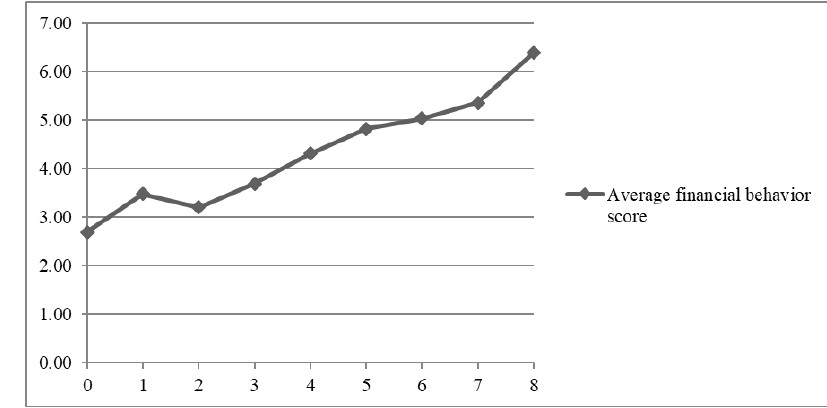
Figure 1: Average Financial Behavior Scores by Financial Knowledge Score